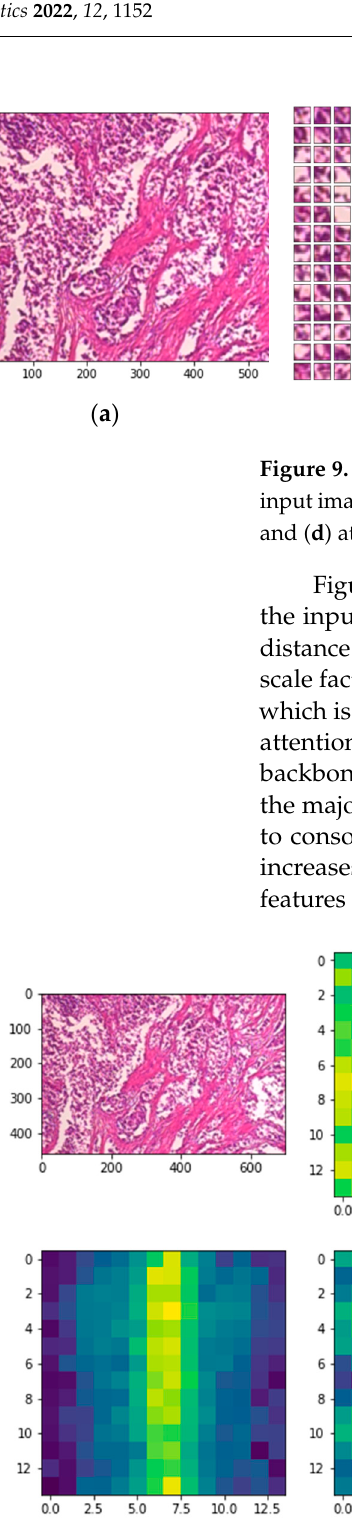
Figure 10. The visualization of the implemented DEEP_Pachi Attention.